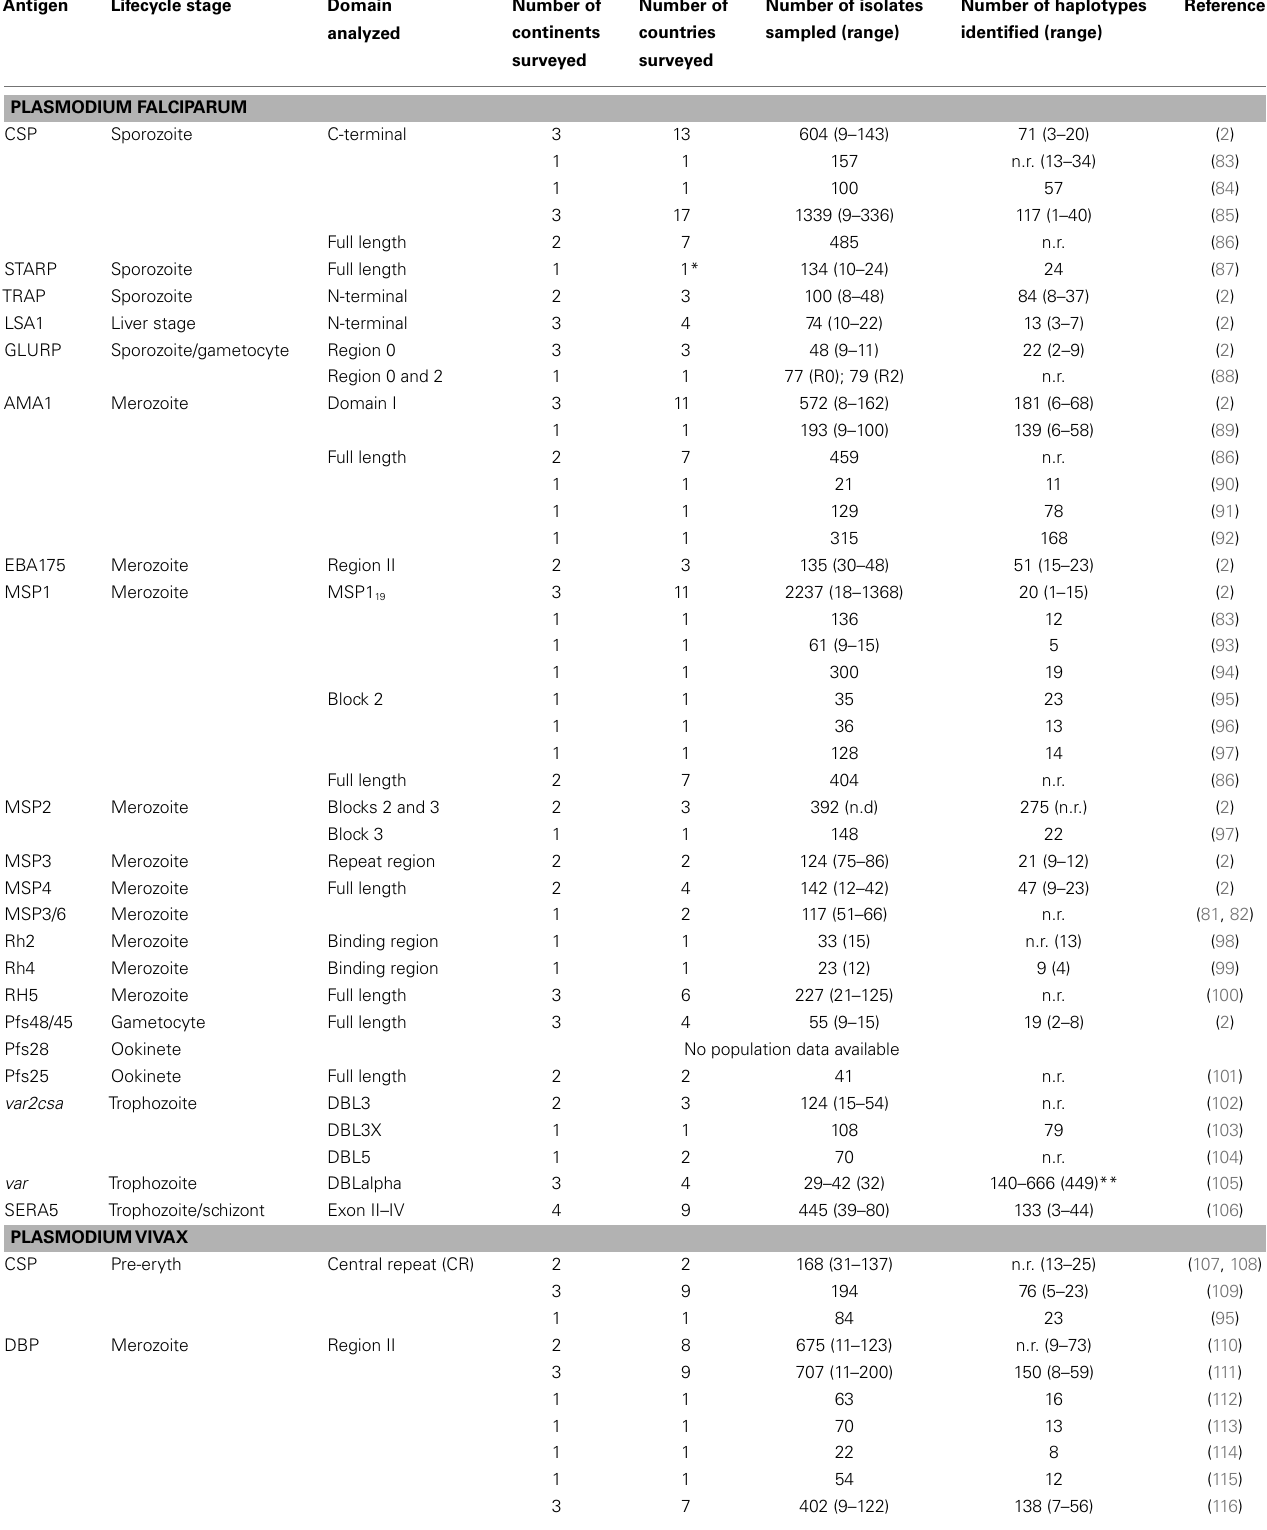
Table 1 | Diversity of malaria vaccine candidate antigens currently in clinical trials based on theWHO rainbow tables (50)